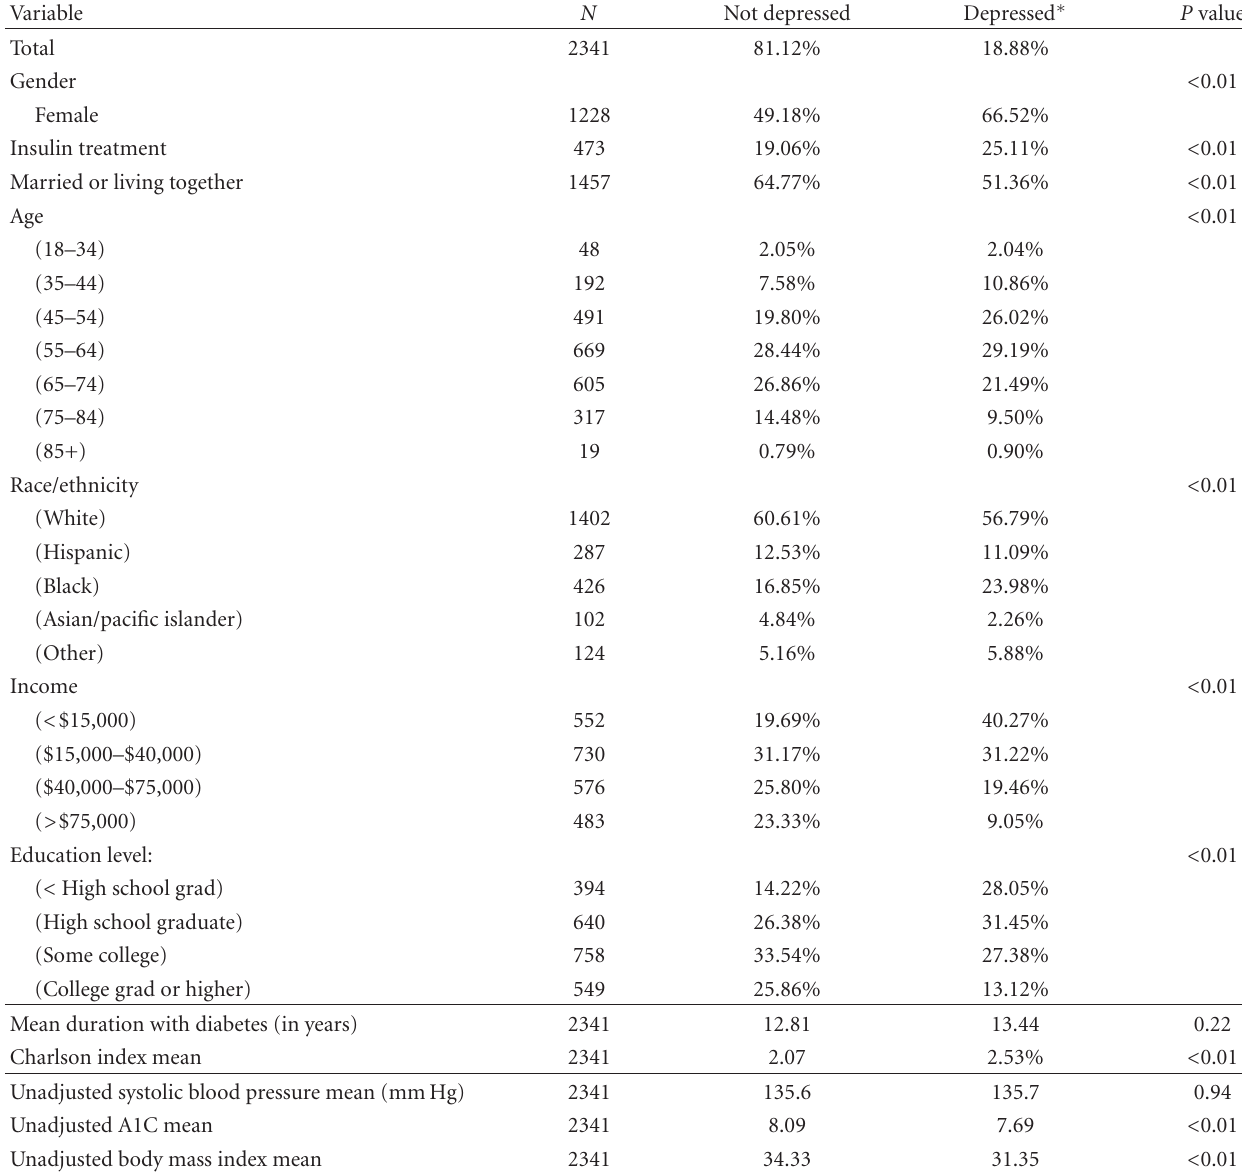
Table 1: Distribution of variables associated with cardiovascular risk factors in study